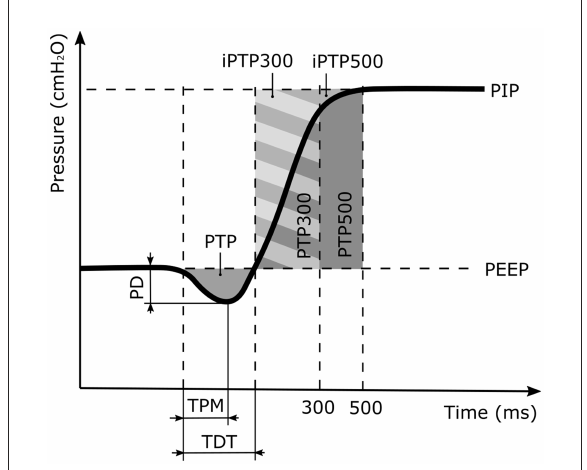
FIGURE2 Illustration of the trigger response and the pressurization capacity parameters, where PD is the pressure drop of the patient effort. TPM is the time between the start of the patient inspiratory to the pressure minimum and TDT the time when the inspiratory pressure equals the positive end expiratory pressure (PEEP) value. PTP is the pressure time capacity defined as the area enclosed by the PD and the TDT. It describes the inspiratory patient effort prior to the ventilator support. The PTP300 and PTP500 values denote the pressurization capacity of the ventilator for the first 300ms and 500ms of the